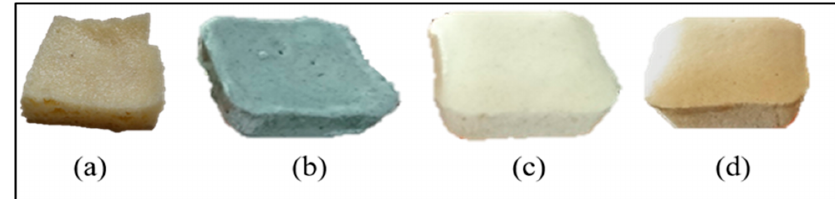
Figure 3. ( a ) COPUF, ( b ) AC/COPUF, ( c ) Z/COPUF, ( d ) B/COPUF.